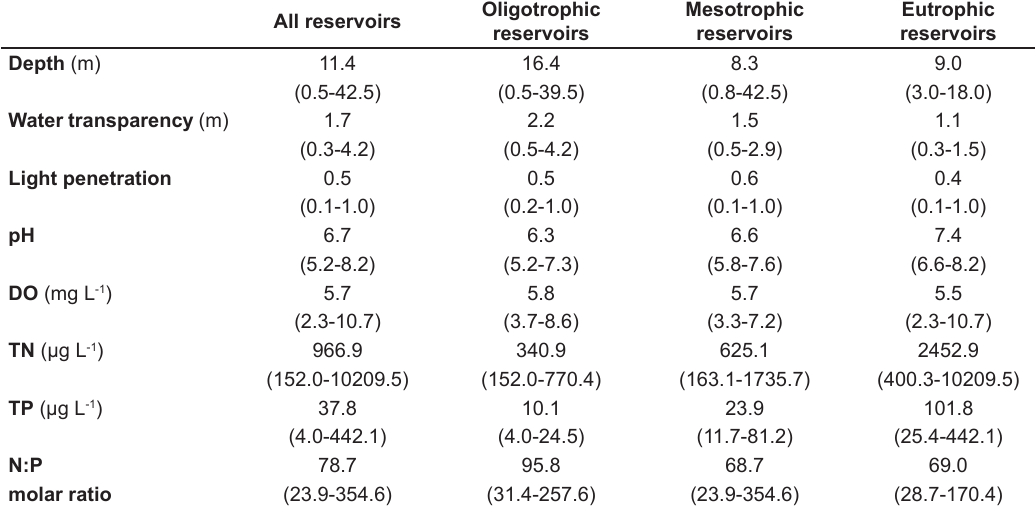
Table 1. Mean (minimum-maximum) of the environmental variables measured in the sampled reservoirs (n = 123 sites).